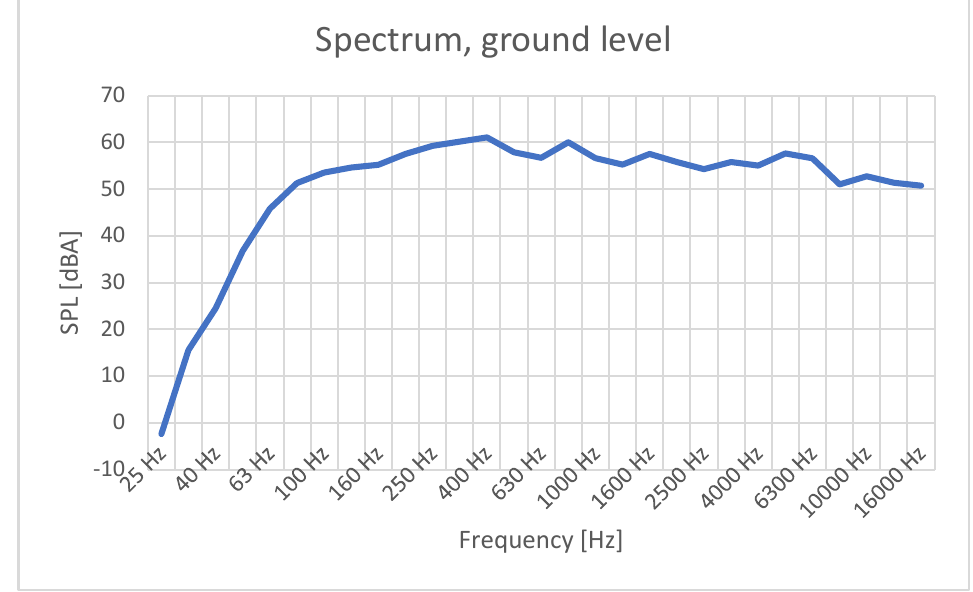
Figure 3. SPL versus frequency recorded in traffic-generated noise measurements, ground level.